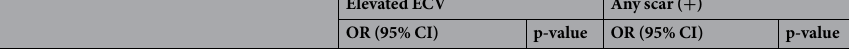
Table 5. Logistic regression analysis of the association of NT-proBNP and high-sensitivity troponin with elevated ECV and scar presence. ECV, Extracellular volume; OR, odds ratio; NT-proBNP, N-terminal pro B-type natriuretic peptide. * Multiple logistic regression model includes NT-proBNP, high-sensitivity troponin, age (years), gender, black (versus non-black), history of diabetes, treatment with diuretics, treatment with